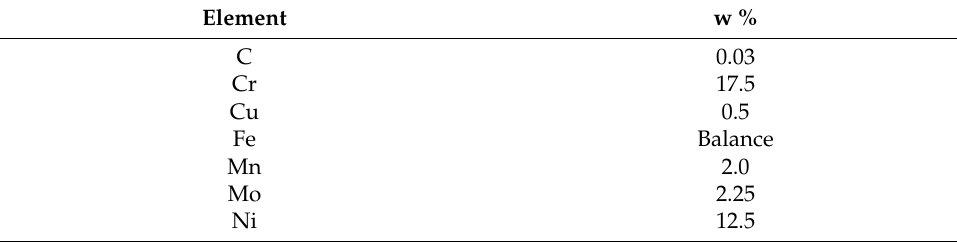
Table 2. Composition of